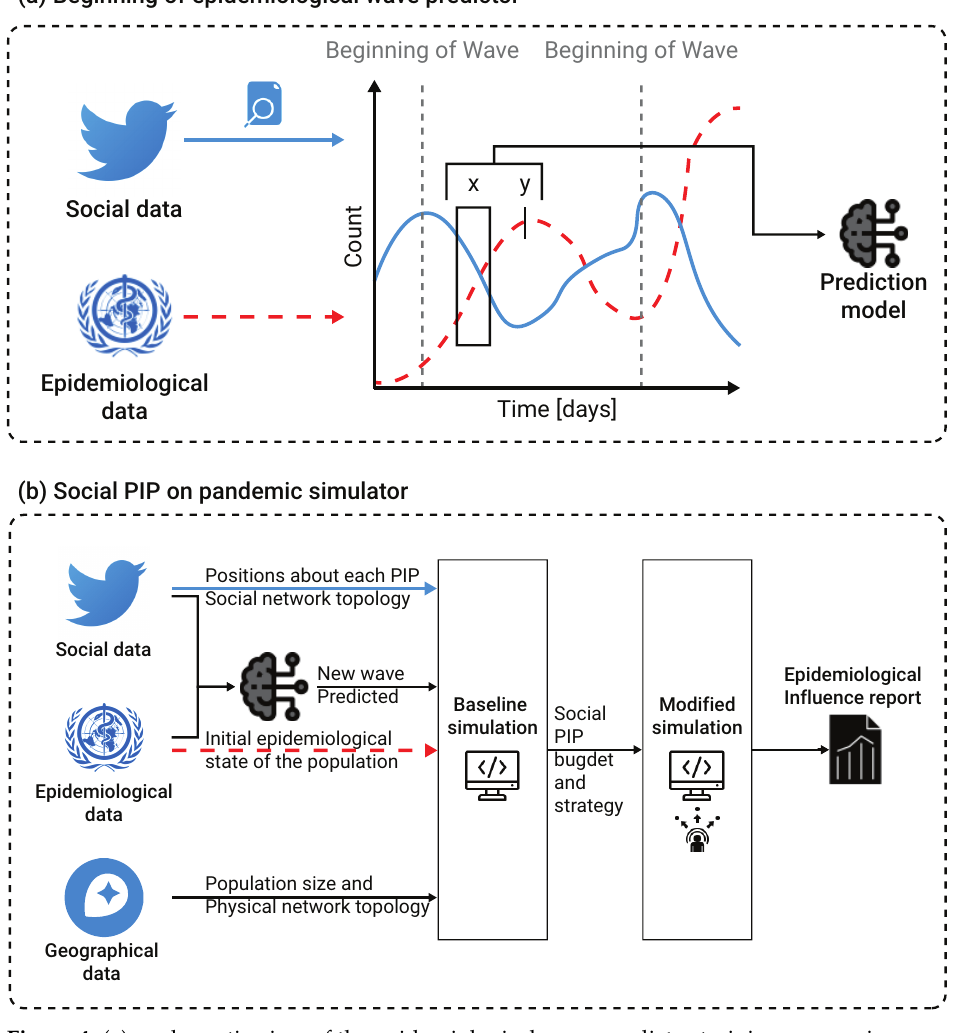
Figure 4. ( a ) a schematic view of the epidemiological wave predictor training process is presented. Namely, we used epidemiological data from WHO [4] and social media data from Twitter, and the natural language processing method to convert the information into time-series data. Using these data, we trained an XGboost model [29] that obtained a moving window on the epidemiological and social data as the input data and binary signal indicating if a beginning of a new epidemiological wave occurs. The solid (blue) line represents the social data while the dashed (red) line represents the epidemiological data. A fixed delay between the input and target data is provided to the model by the user. ( b ) a schematic view of the social PIP’s evaluation is presented. In order to use the spatial component of the proposed extended SIR model, geographical and sociological data in the form of population size and physical network topology are introduced. Based on these data, a baseline simulation was computed. Afterward, the user defines a social PIP strategy and budget and re-computes the modified simulation. EMIT reports the differences between the two runs as the influence of the social